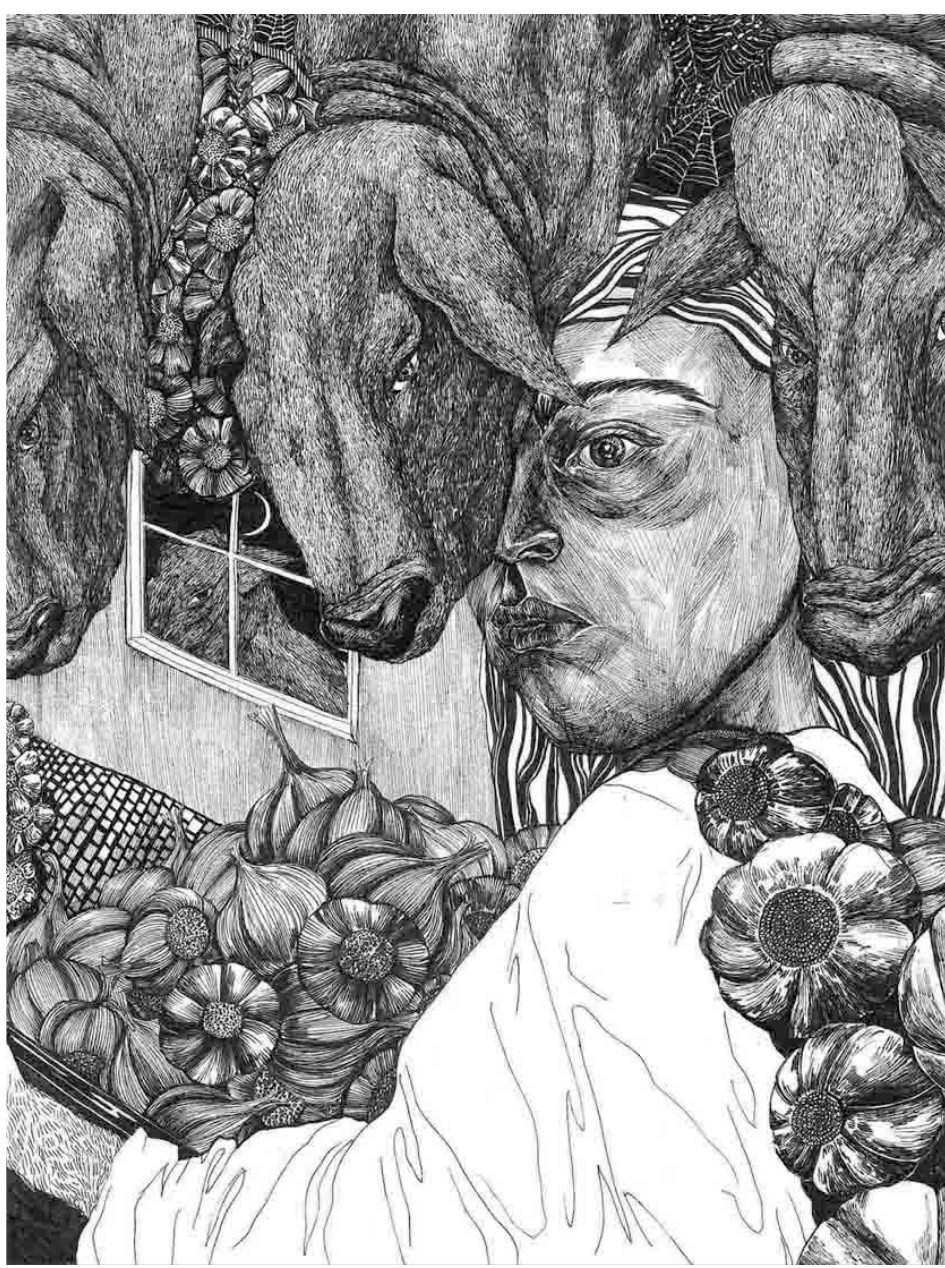
Rosabel Rosalind Kurth-Sofer, Exodus IX , 2018. Pen and ink on paper. 9x11